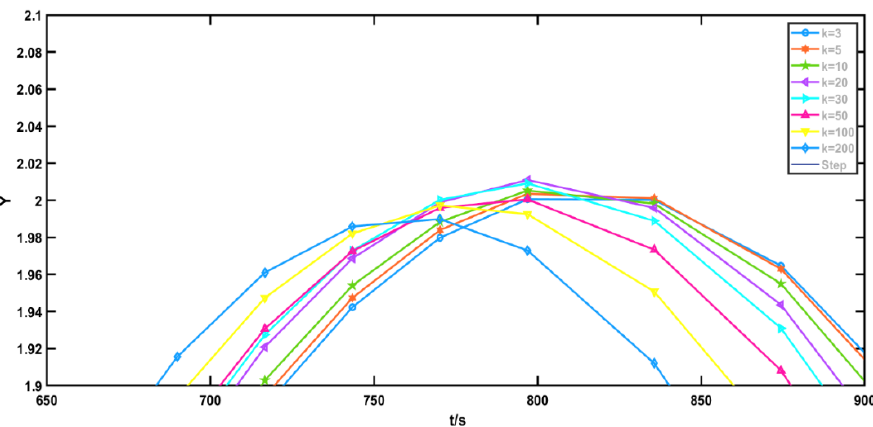
Figure 11. Local Magnification for Figure 10.